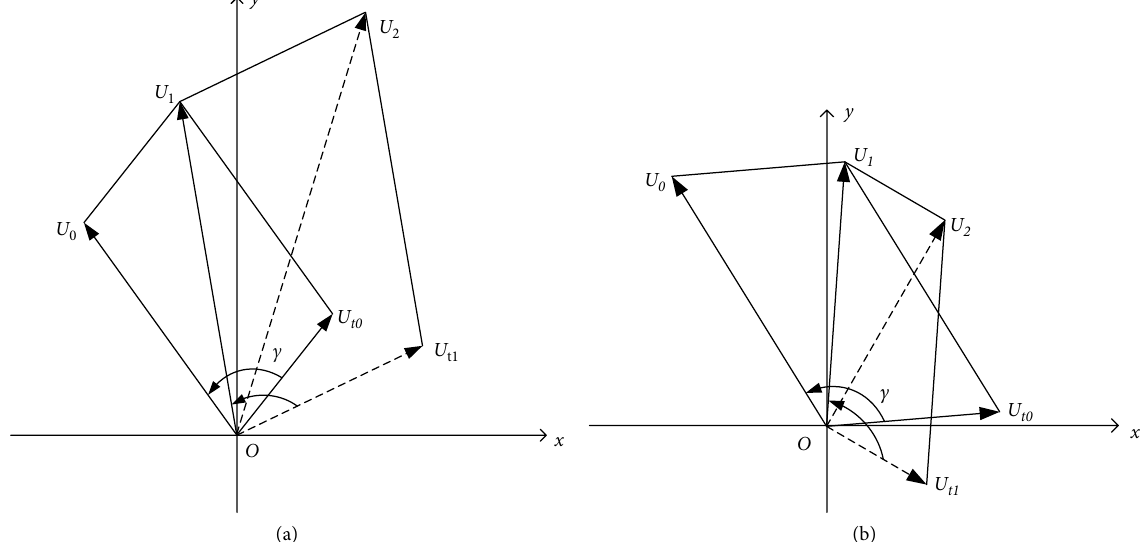
Figure 7: Resultant, thermal, and initial unbalance. (a) Below critical rotational speed. (b) Above critical rotational speed.